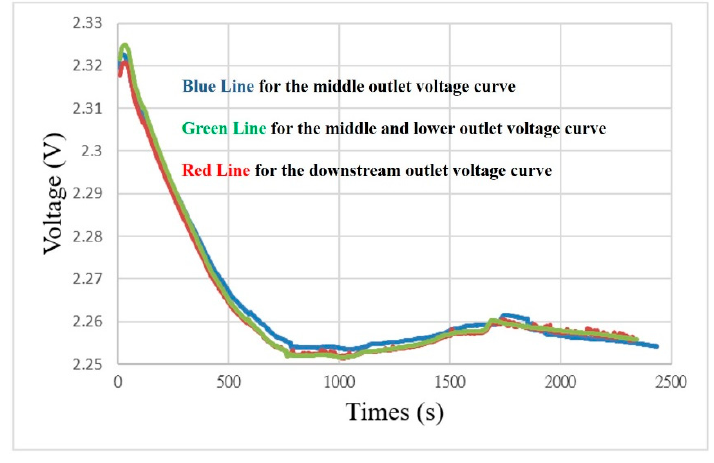
Figure 9. Voltage curve diagram of different runners.